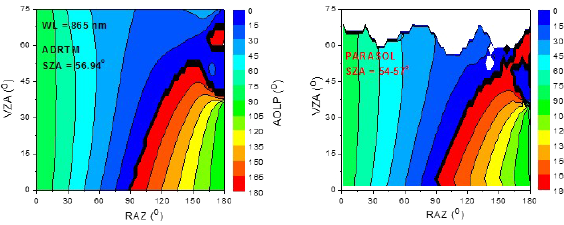
Figure 19. Comparison of the modeled AOLP of desert-reflected solar light with those from the PARASOL data at the wavelength of 865nm. The SZA is 56.94 ◦ in the modeling. The SZA is in the bin of 54–57 ◦ for the PARASOL